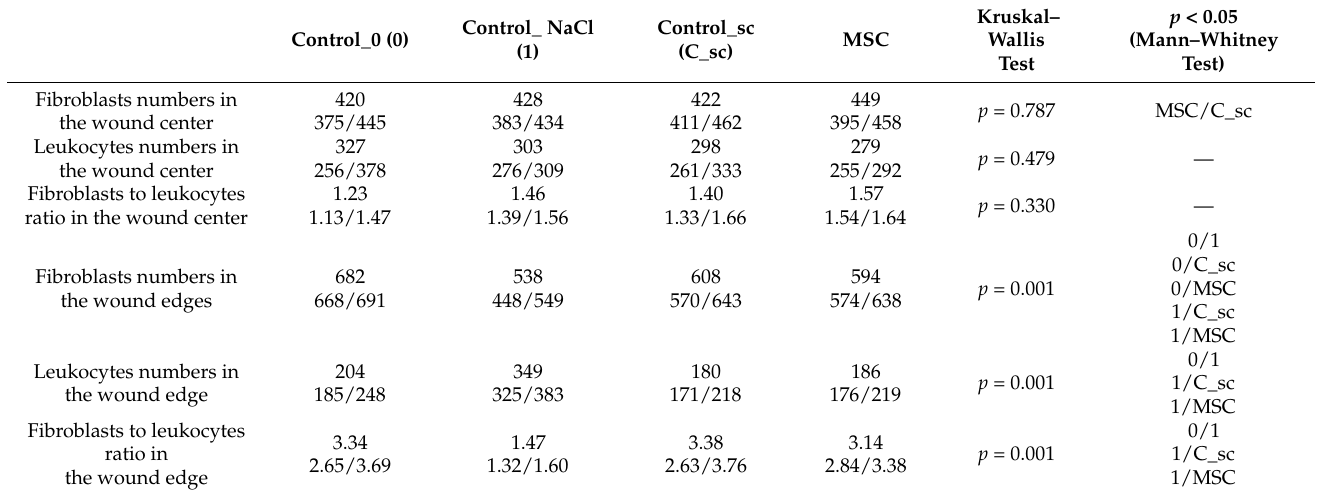
Table 2. Number of fibroblasts and leukocytes in the wound center and wound edges of different groups on day 7